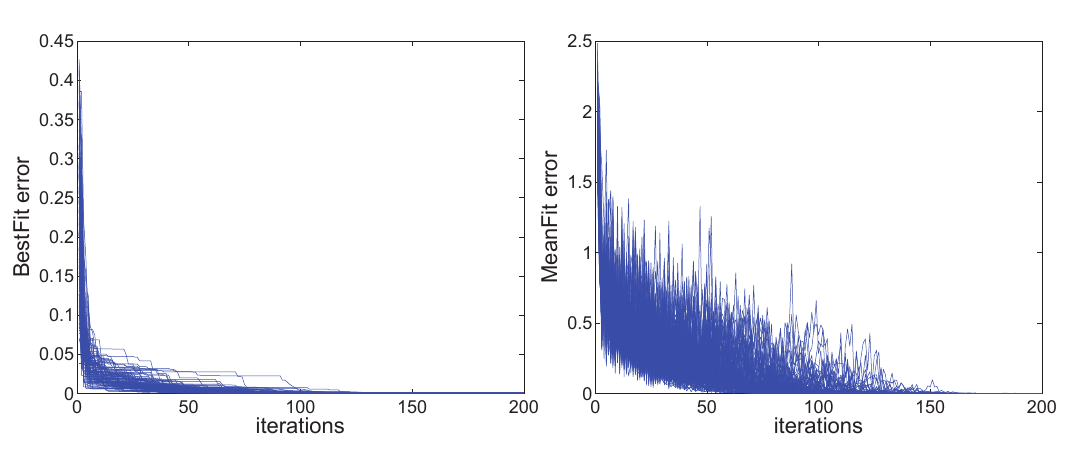
Figure 13. The convergence of error in the individual best position (BestFiterror) and global best position (Meanfiterror).